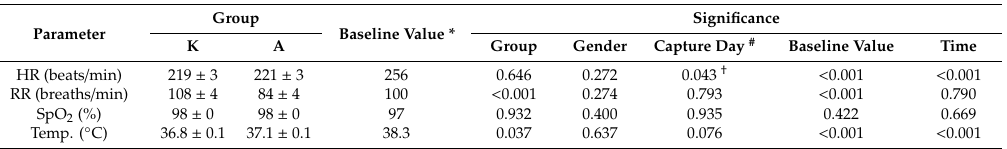
Table 4. Physiologic parameters monitored continuously in wild gray squirrels undergoing gonadectomy and randomized to receive two anesthetic mixtures IM: Ketamine-dexmedetomidine- midazolam (group K, n = 25) and alfaxalone-dexmedetomidine-midazolam (group A, n = 22). Values are estimated marginal means ± standard